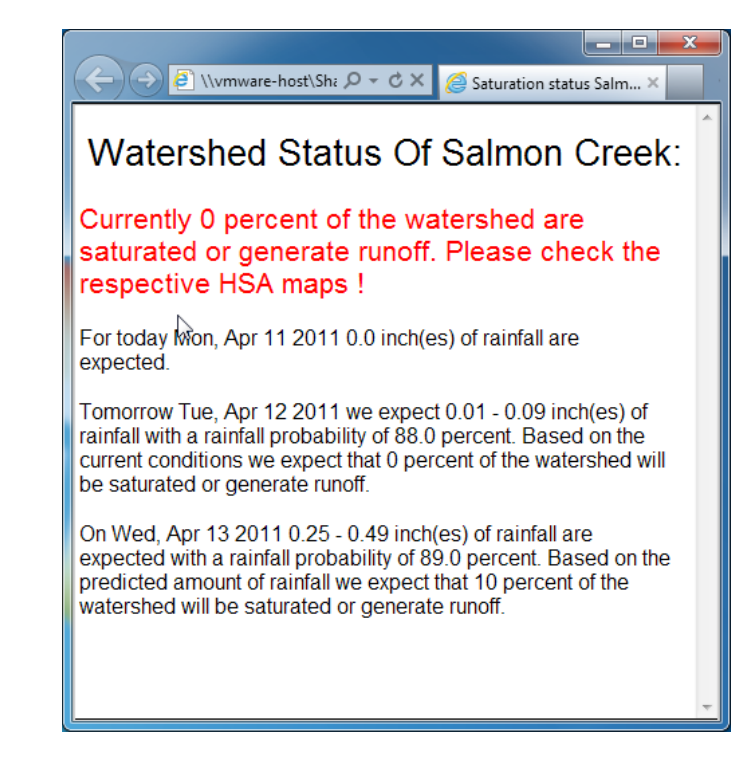
Figure 3. Daily updated status report showing the forecasted rainfall amounts, the probability of precipitation for each projected 24 h period, and the expected percent area of the watershed that could saturate or generate